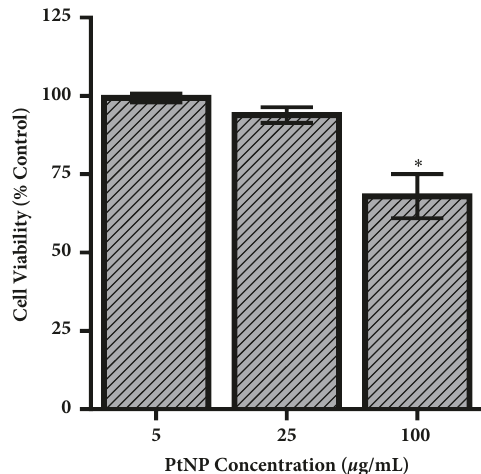
Figure 2: HepG2 viability following PtNP exposure. HepG2 liver cells underwent a 24-hour exposure to PtNPs at varying dosages, followed by evaluation of cellular viability. At the highest PtNP dosage, a significant toxicity response was observed. Data represents 3 independent trials with ∗ denoting statistical significance from untreated controls ( p <